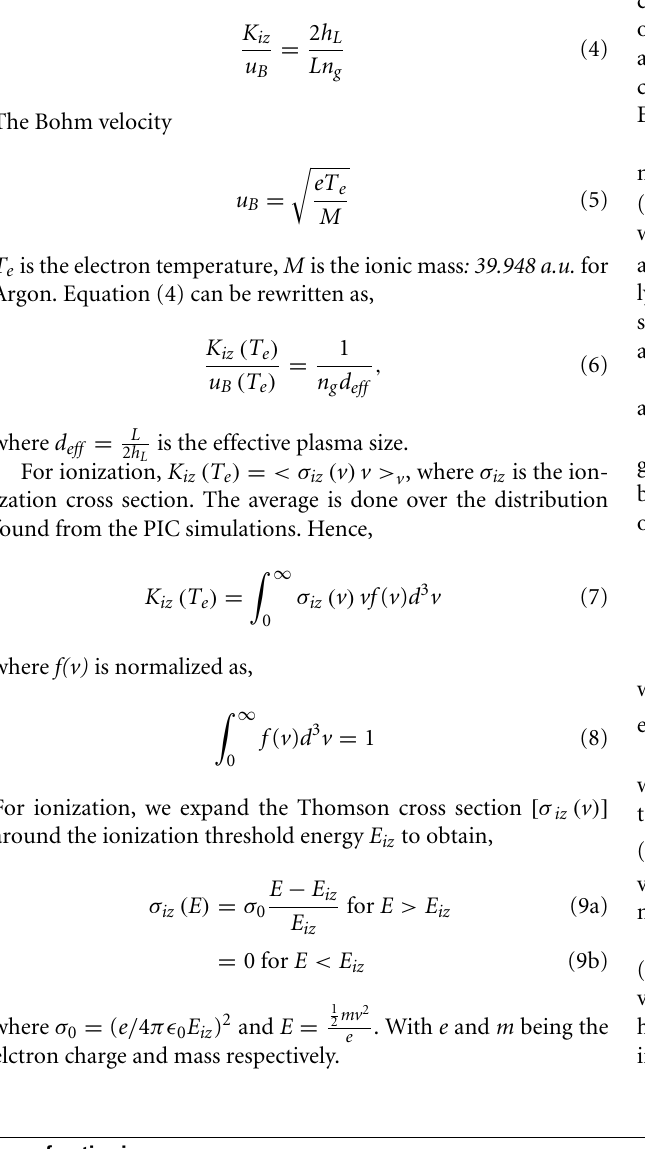
cm, where p is in 330 p